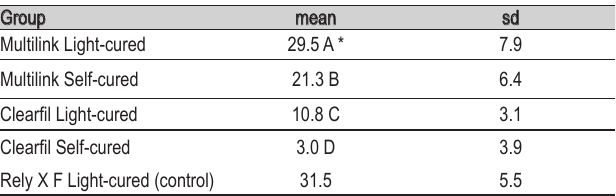
Table 2 - The bond strengths means (and standard deviation) in MPa for the resin cements tested.